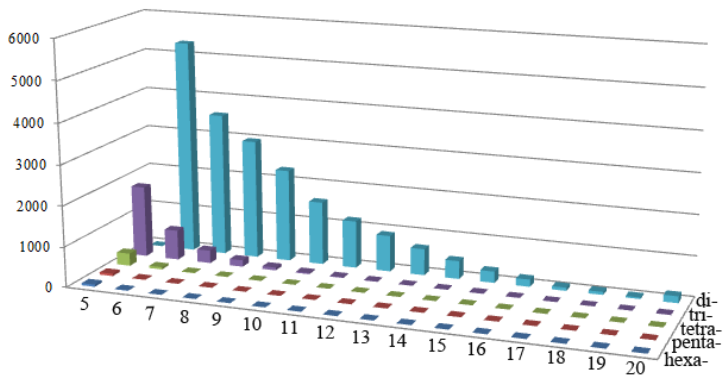
Figure 1. Distribution of various classes of simple repeat motifs with different numbers of repeats in the sesame